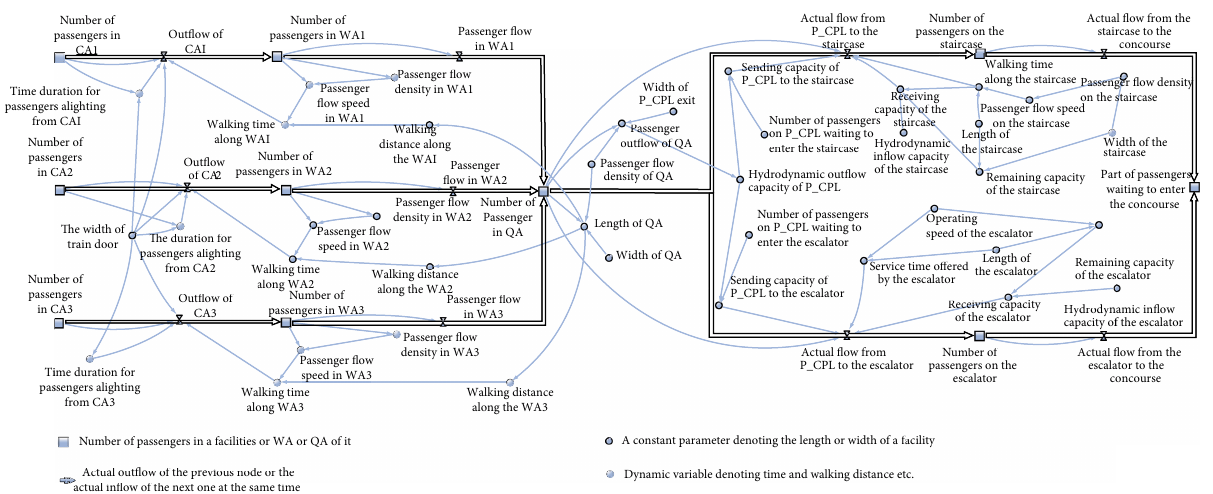
Figure 11: Stock-flow diagram for leaving